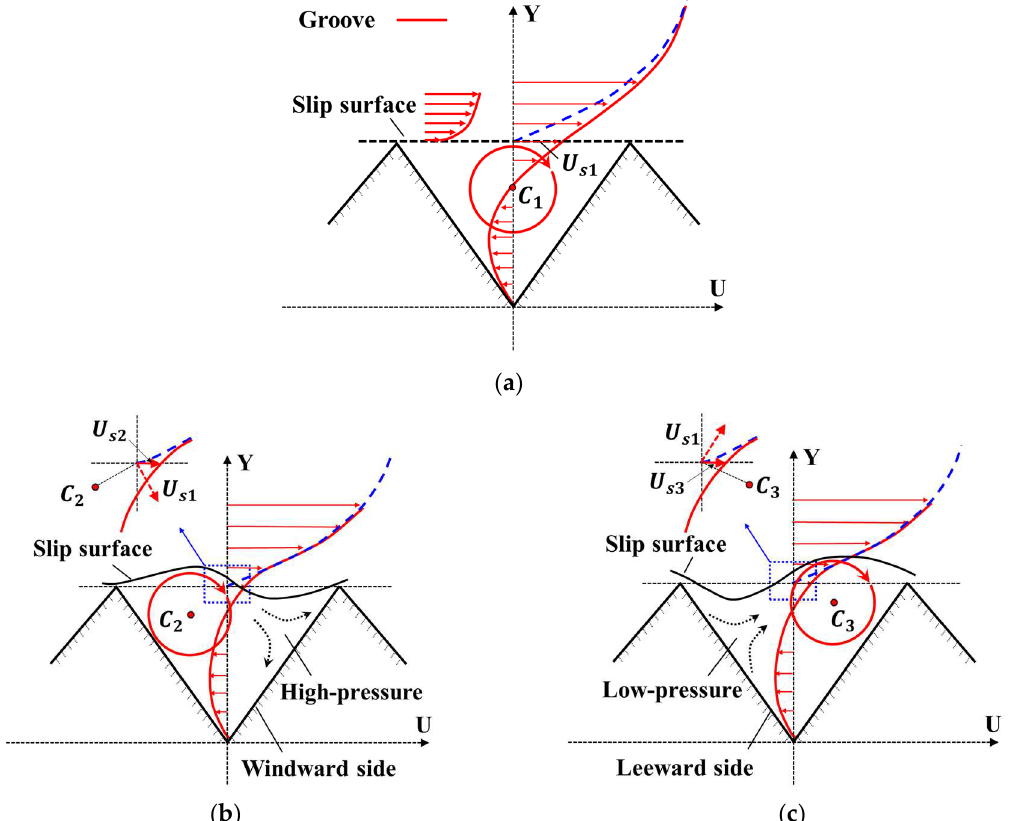
Figure 2. Influence of the stability of boundary vortex on drag-reduction performance. ( a ) Stable boundary vortex; ( b ) boundary vortex moves upstream; ( c ) boundary vortex moves downstream.